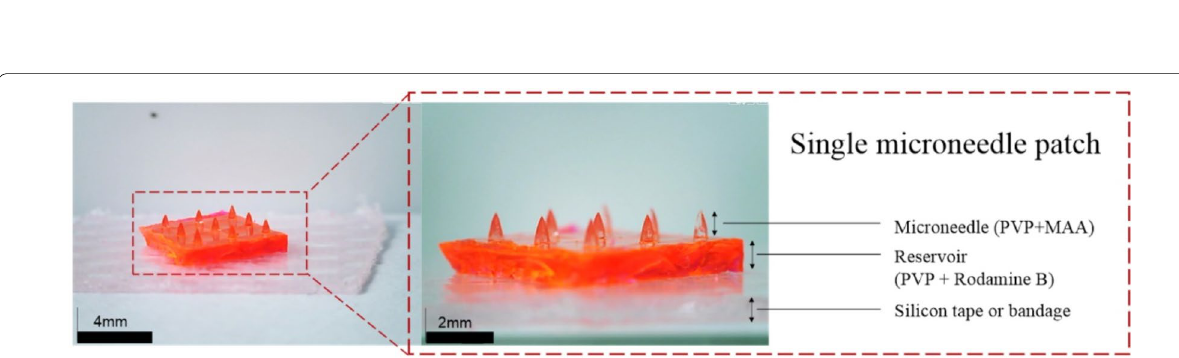
Fig. 6 Images of the biodegradable PVP‑MAA microneedle patch with drug reservoir base. Rhodamine B was loaded in the thick PVP‑MAA base to resemble allergy